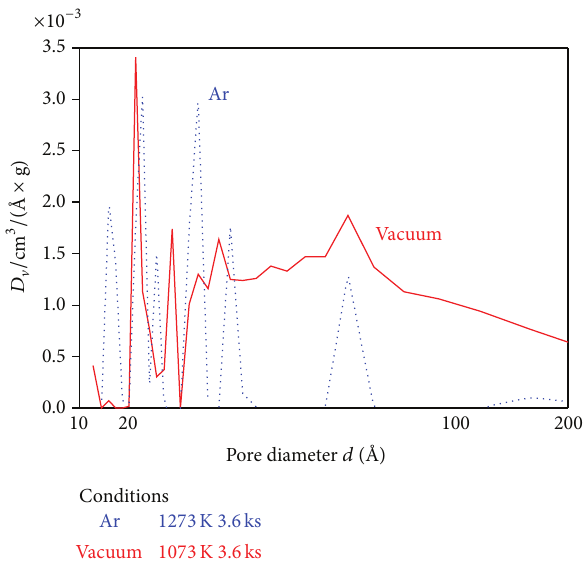
Figure 10: Pore diameter distribution of dolomite pyrolysis prod-